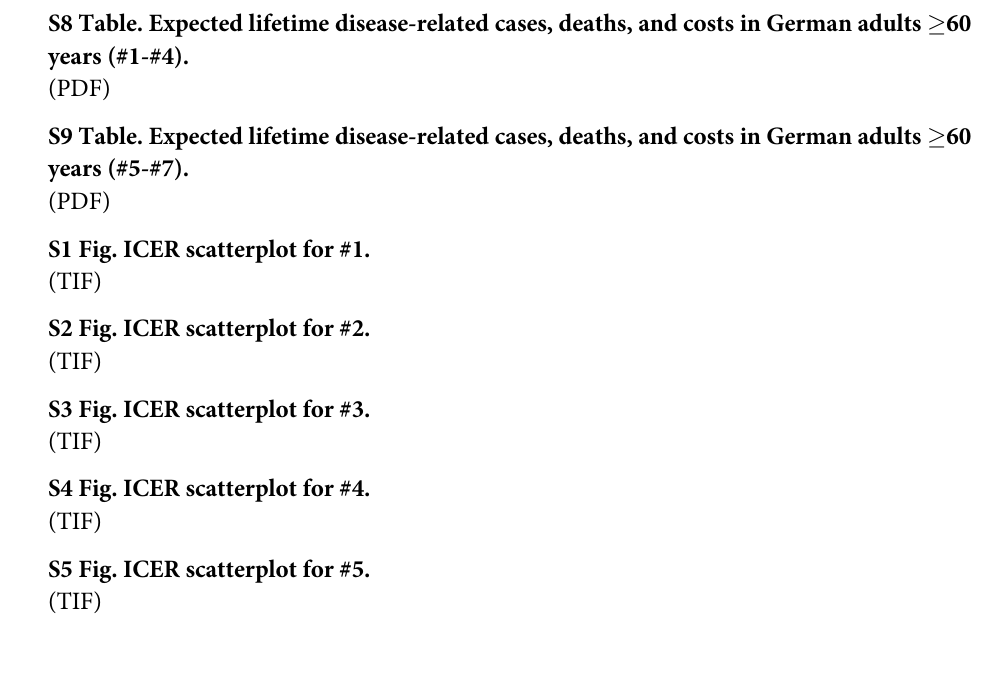
S1 Table. Model fits for serotype distribution IPD over time (incl. prognosis for next 5 years). S2 Table. Development of herd effect by year of modelling (cumulative in %) based on ST- specific IPD data. S3 Table. Distribution of PSA parameters. S4 Table. Expected lifetime disease-related cases, deaths, and costs in German adults #1- #4. S5 Table. Expected lifetime disease-related cases, deaths, and costs in German adults #5- #7. S6 Table. Expected lifetime disease-related cases, deaths, and costs in German adults < 60 years (#1-#4). S7 Table. Expected lifetime disease-related cases, deaths, and costs in German adults < 60 years (#5-#8). S8 Table. Expected lifetime disease-related cases, deaths, and costs in German adults (cid:21) 60 years (#1-#4). S9 Table. Expected lifetime disease-related cases, deaths, and costs in German adults (cid:21) 60